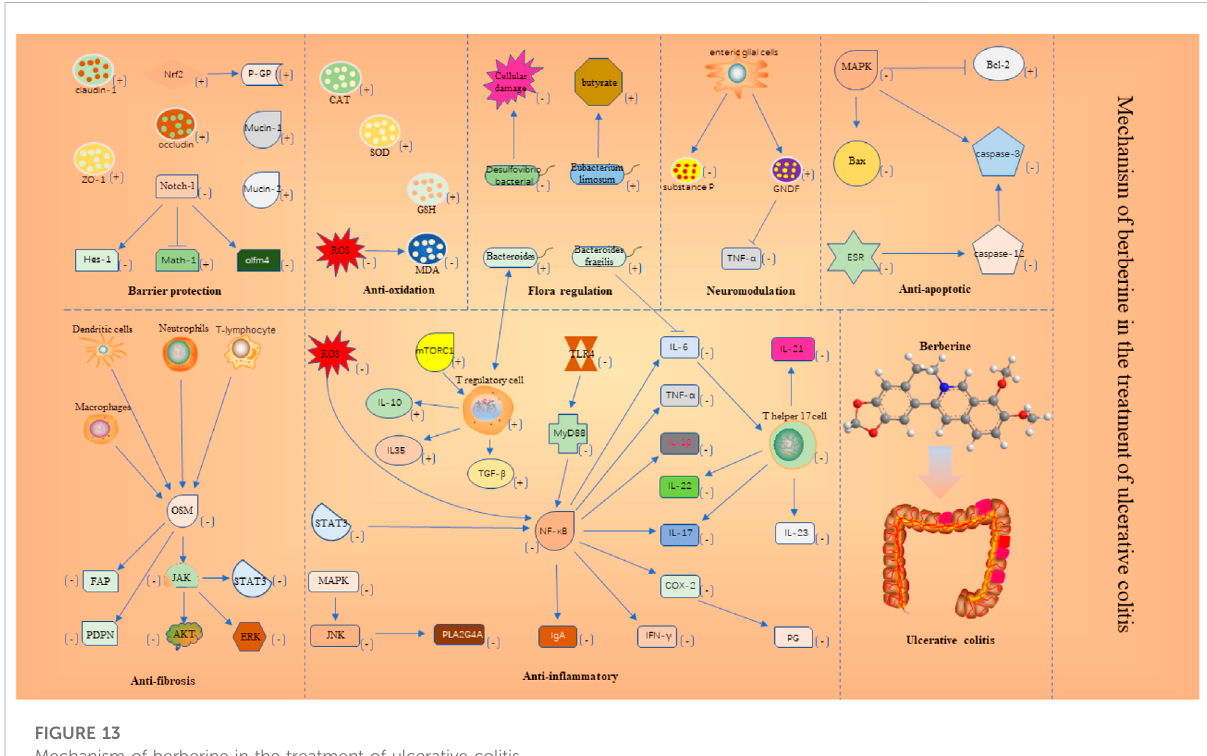
FIGURE 13 Mechanism of berberine in the treatment of ulcerative